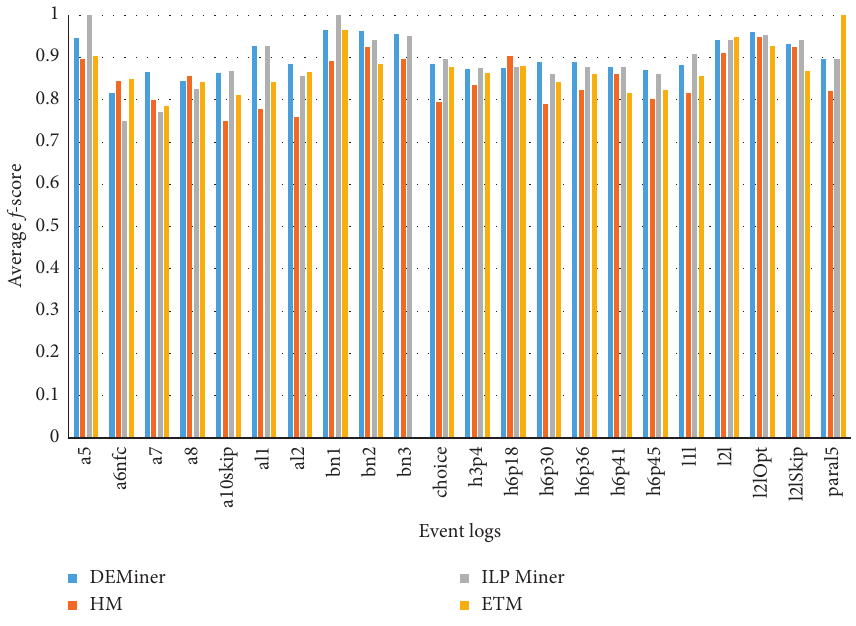
Figure 7: Average f -score of four algorithms on 22 event logs with 5% noise. Table 7: Comparison of four algorithms’ performance on 22 event logs with 10%